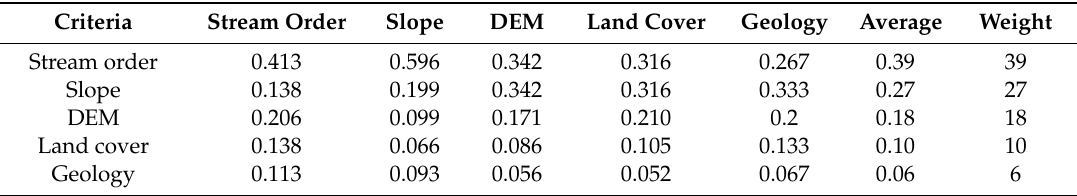
Table 4. Normalized